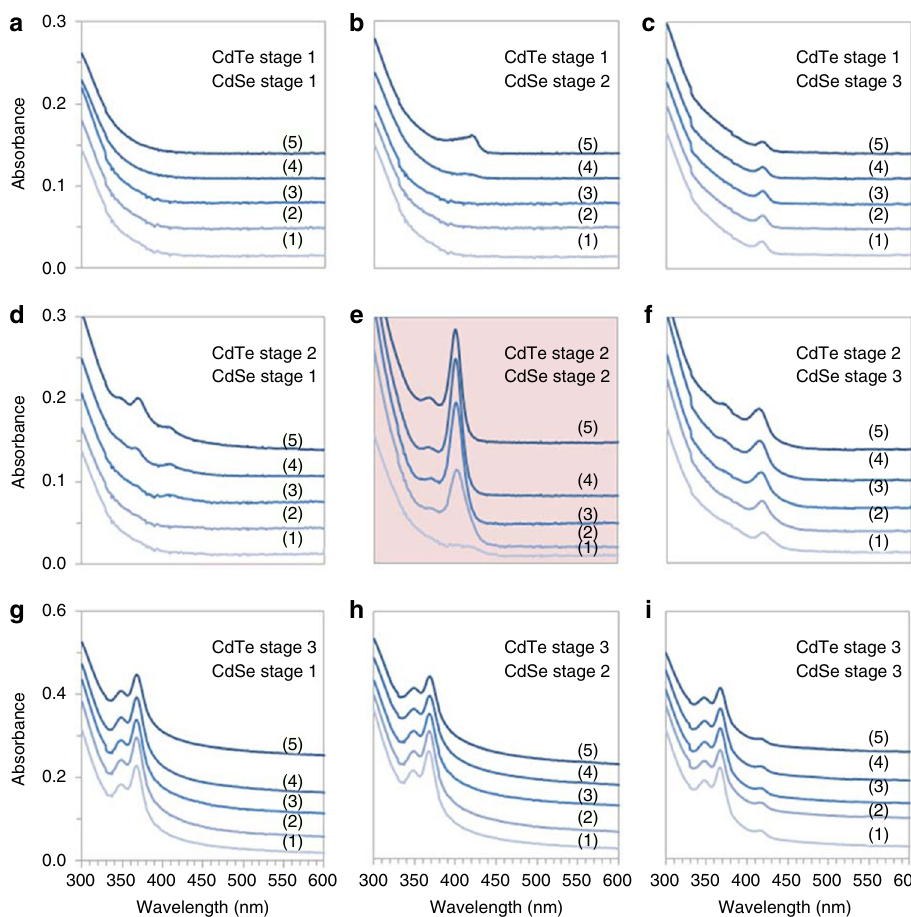
Fig. 5 Optical absorption spectra of nine mixtures of CdTe and CdSe. There are nine mixtures prepared by mixing CdTe and CdSe samples in Stages 1 and 1 ( a ), 1 and 2 ( b ), 1 and 3 ( c ), 2 and 1 ( d ), 2 and 2 ( e ), 2 and 3 ( f ), 3 and 1 ( g ), 3 and 2 ( h ), and 3 and 3 ( i ), at room temperature with equal volumes. The mixtures were incubated for (1) 0 min, (2) 1 h, (3) 2 h, (4) 4 h, and (5) 8 h. Each of the mixtures (30 μ L) was dispersed in toluene (3.0 mL). Interestingly, MSC-399 was well evolved only from the mixture shown in Part e with the mixture of Stage 2 CdTe and CdSe. Stage 1 means when two precursors of Cd and Te or Cd and Se were put together at room temperature; after Stage 1 samples were heated for 30 min at 130 °C for CdTe or at 140 °C for CdSe, they are referred as Stage 2 (induction period) samples. When the Stage 2 samples were incubated at room temperature for 24 h, they are called Stage 3 samples (with the presence of CdTe MSC-371 or CdSe